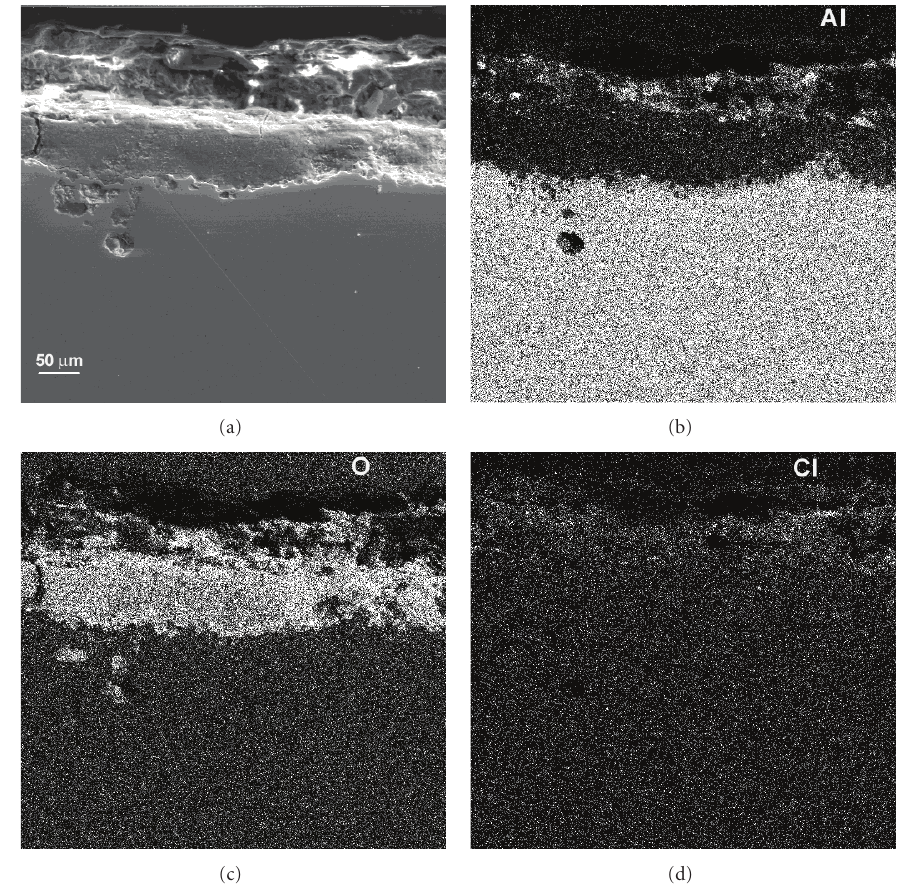
Figure 9: Micrograph of Fe40Al + 3Li alloy corroded in NaCl-KCl at 670 ◦ C together with the X-ray mappings of Al, O, and